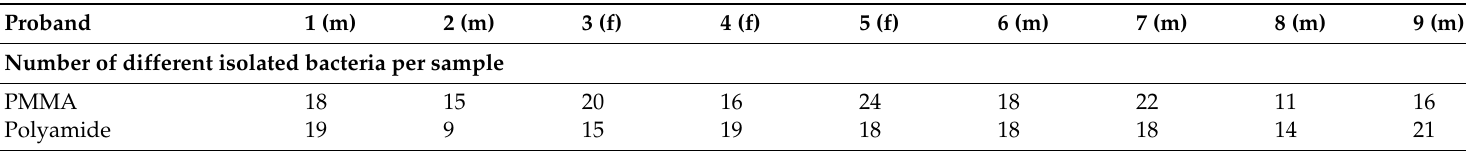
Table 2. Occurrence of most frequent isolated